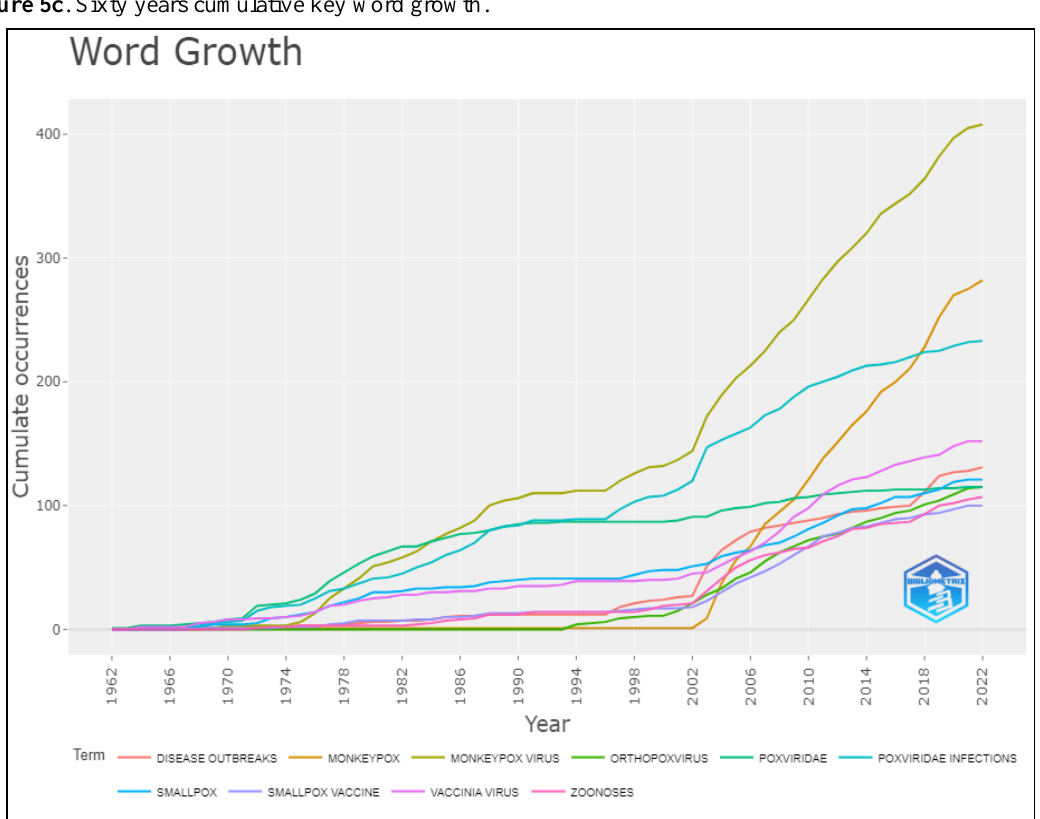
Figure 5c . Sixty years cumulative key word